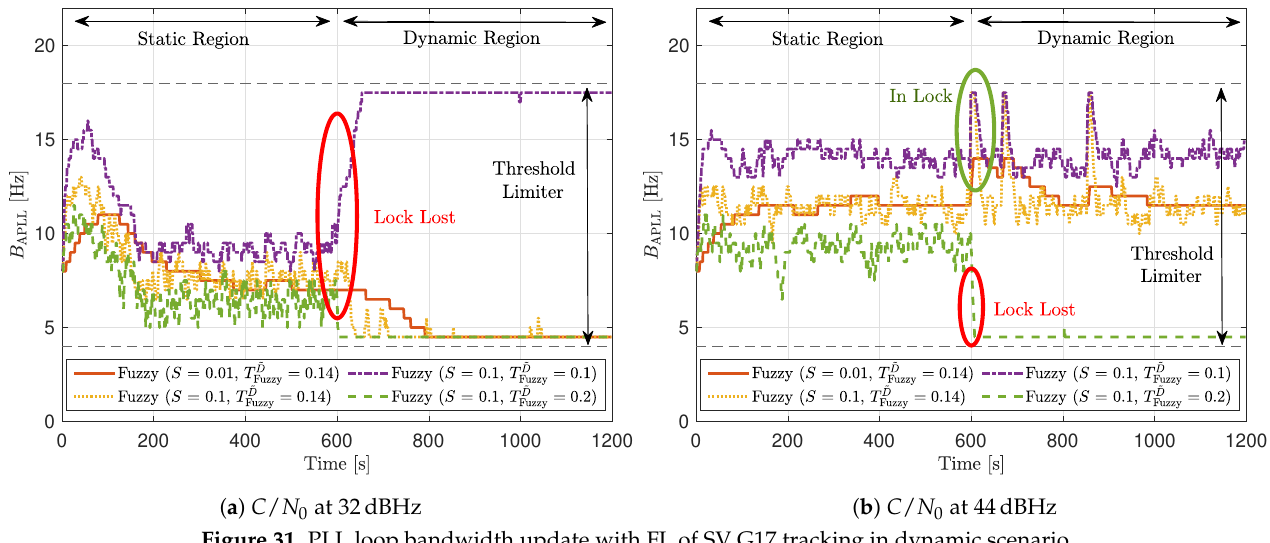
Figure 31. PLL loop bandwidth update with FL of SV G17 tracking in dynamic scenario.